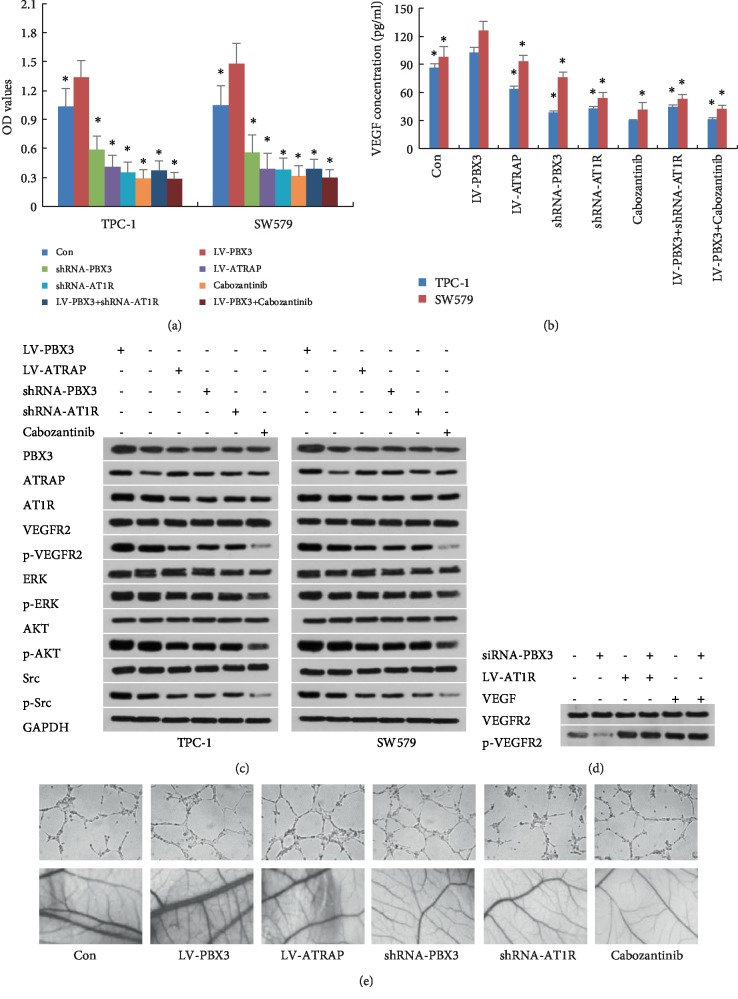
PBX3 promoted PTC cell proliferation and angiogenesis via activation of AT1R/VEGFR2 pathway. (a) Overexpression of ATRAP, knockdown of AT1R or cabozantinib treatment inhibited PTC cell proliferation, (b) inhibited VEGF production in cell culture, and (c) induced downregulation of VEGFR2 and its downstream (p-ERK1/2, p-AKT and p-Src). (d) AT1R overexpression and VEGFA administration rescued shRNA-PBX3-inhibited phosphorylation of VEGFR2. (e) The tube branch points of HUVECs (magnification, ×10) and angiogenesis of chick chorioallantoic membrane (magnification, ×10) induced by tumor conditioned medium treated with LV-PBX3, shRNA-PBX3, LV-ATRAP, shRNA-AT1R or cabozantinib. All values are shown as mean ± SD. ∗P0.05 versus control group.